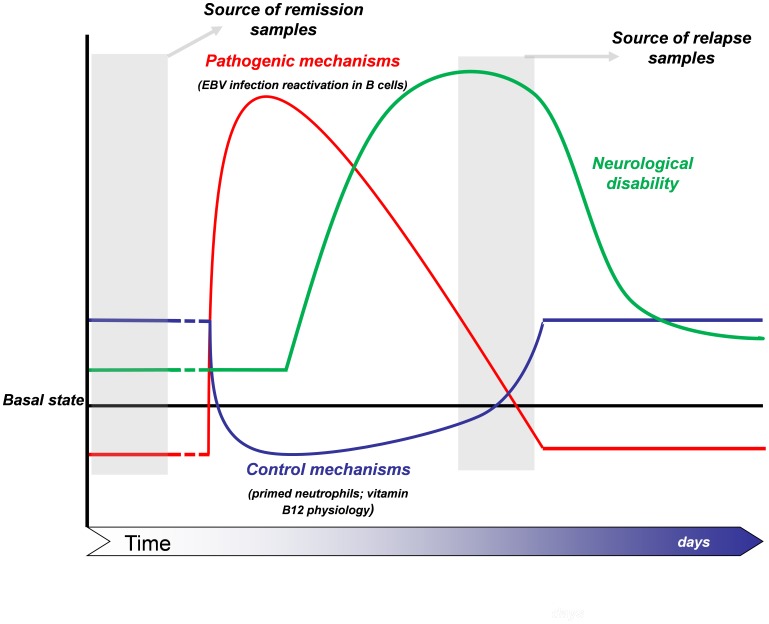
Theoretical model for the relapsing-remitting molecular dynamics responsible for disease progression of RRMS in female patients.